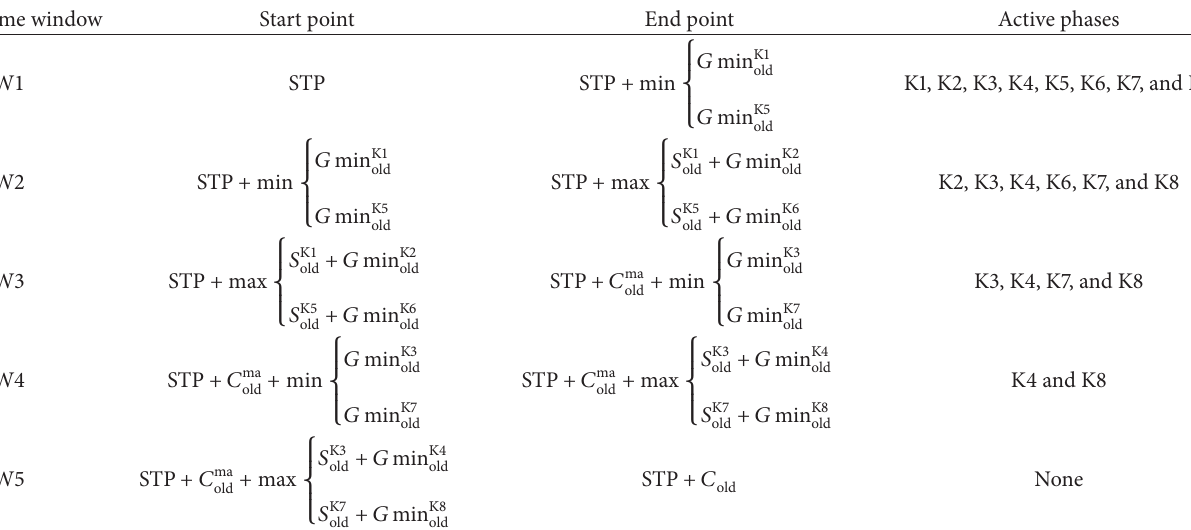
Figure 3: Sync reference points illustrated. Table 1: Time window definition